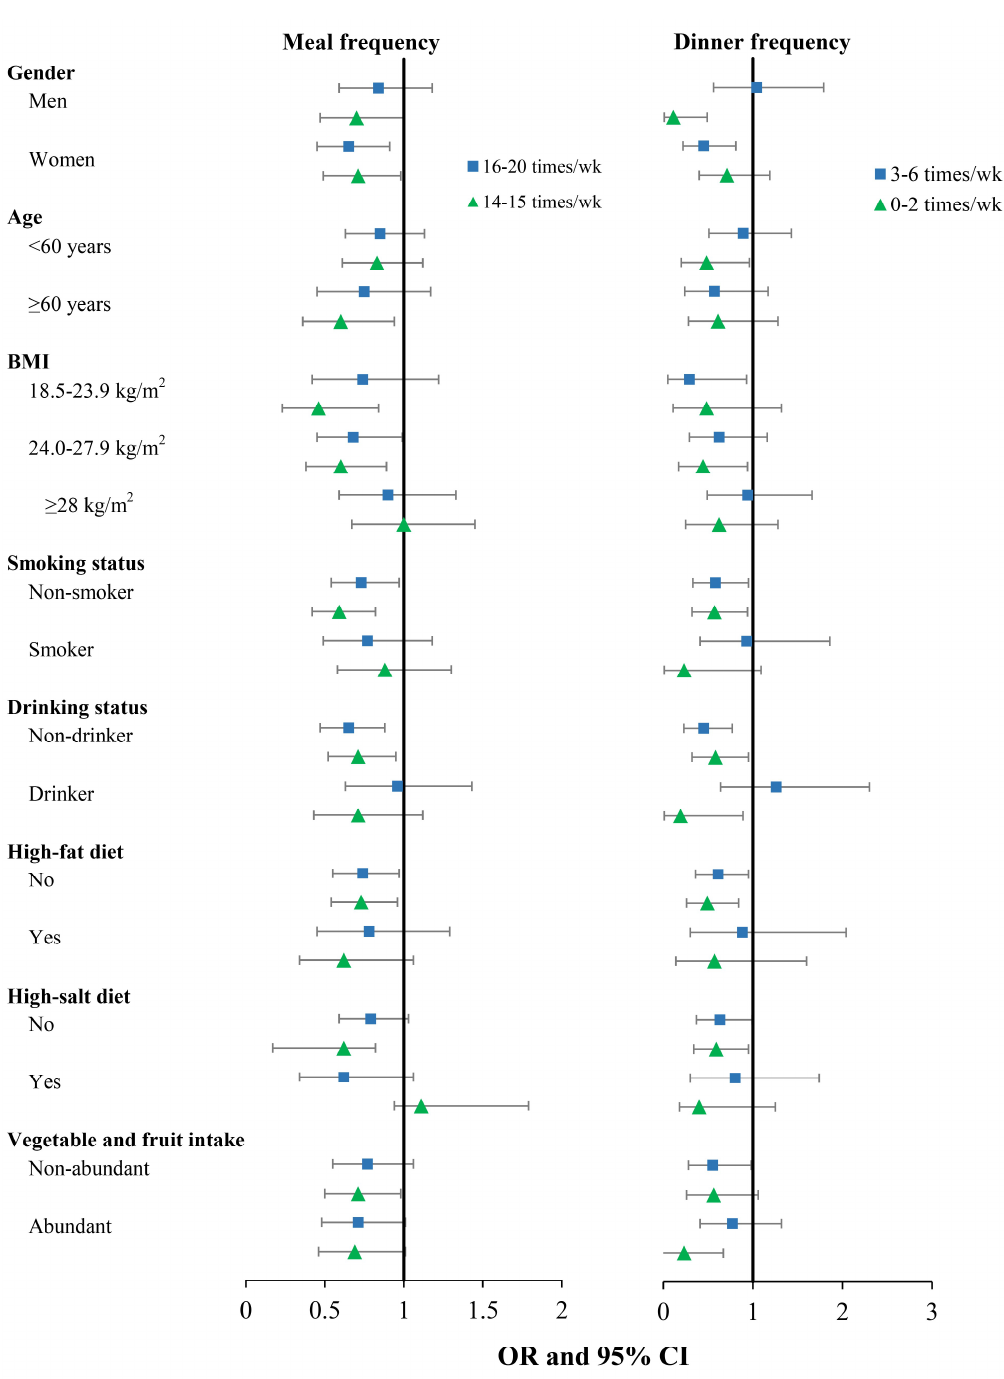
Figure 1. Stratified analysis of the association between weekly meal frequency, dinner frequency and T2DM. Notes: 21 times per week and seven times per week as references, respectively.